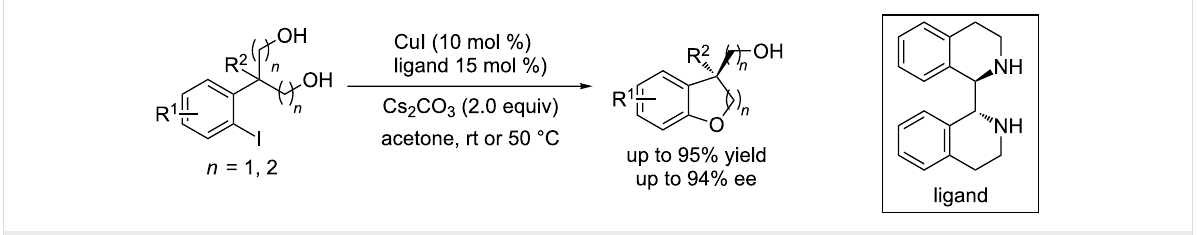
Scheme 23: Copper-catalyzed intramolecular desymmetric aryl C–O coupling.